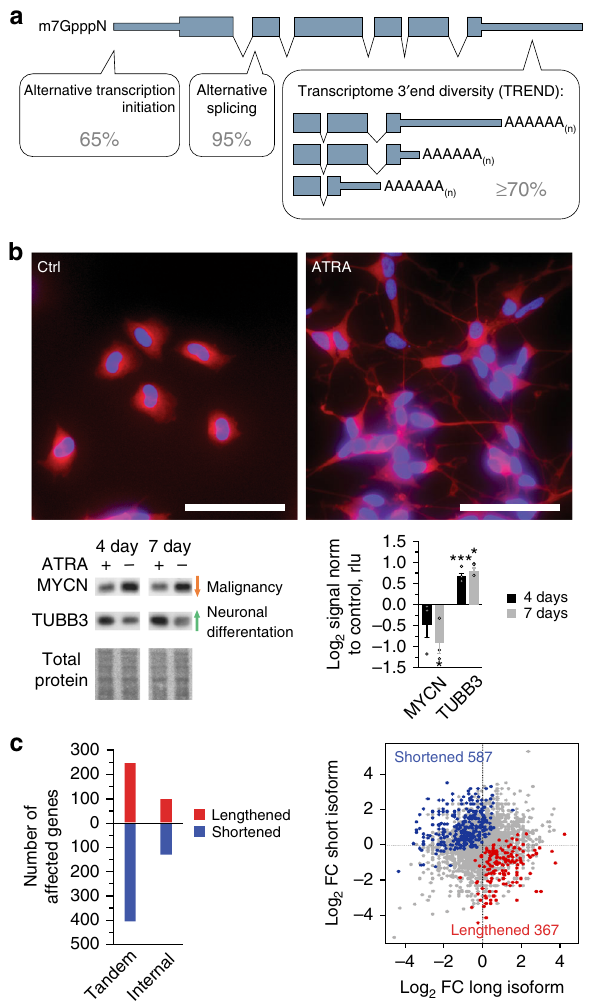
Fig. 1 Pervasive alteration of transcriptome 3 ′ end diversi fi cation (TREND) in childhood neuroblastoma. a The genome complexity is considerably expanded by co- and post-transcriptional processes. Various mechanisms including alternative polyadenylation (APA) can result in transcriptome 3 ′ end diversi fi cation (TREND) affecting the coding sequence and/or 3 ′ untranslated regions (UTR). More than 70% of all genes expressed have alternative 3 ′ ends, thus shaping the transcriptome complexity to a similar extent as alternative splicing (95%) or alternative transcription initiation (65%). b BE(2)-C neuroblastoma model for all- trans retinoic acid (ATRA) induced neurodifferentiation (scale bar 100 µ m). Western blot of molecular markers re fl ecting neuronal differentiation in response to ATRA treatment (mean ± s.e.m. for three replicates, one-sided t -test p -value, * p < 0.05, *** p < 0.001; cells are stained with an antibody directed against TUBB3 (red), nuclei are stained with DAPI (blue)). c Differentiation results in a widespread TREND regulation leading to the expression of lengthened (red) and shortened (blue) transcript isoforms, mainly affecting the 3 ′ UTR ( ‘ tandem ’ ; also depicted in the scatter plot on the right) compared to relatively fewer events affecting the open reading frame ( ‘ internal ’ ; FC fold